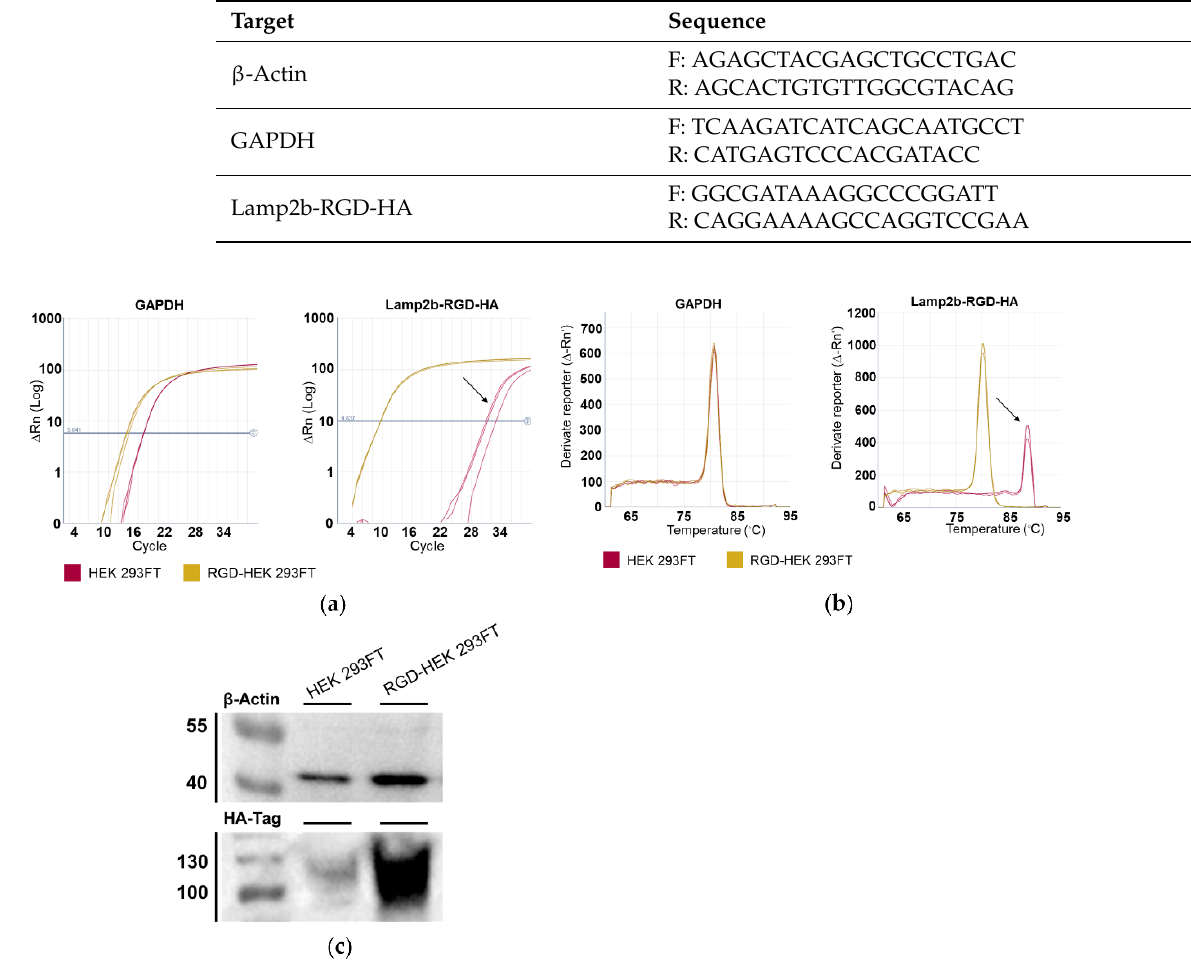
Figure A1. RT-qPCR and Western blot verification of HEK 293FT cells after zeocin-based resistance selection. ( a ) Amplification curves of Lamp2b-RGD-HA and GAPDH cDNA show retention of strong expression of Lamp2b-RGD-HA characterised by early amplification and detection. ( b ) Dissociation curves of amplified products. Arrow indicates nonspecific PCR product in parental HEK 293FT cDNA. ( c ) Western blot image of HEK 293FT and RGD-HEK 293FT cell lysates.